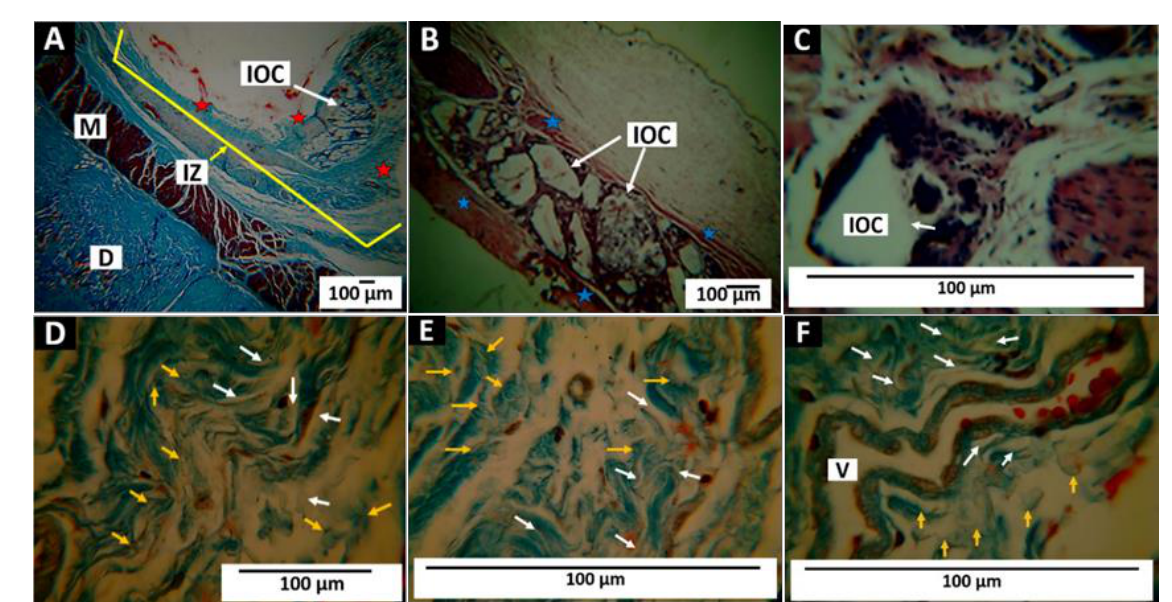
Figure 12. Subdermal implantation of F2 (InterOss Collagen). ( A ) Image at 4×. TM technique. ( B ) Image at 10×. H-E technique. ( C ) Image at 100×. H-E technique. ( D ) Image at 100×. MT technique. ( E ) 100×. TM technique. ( F ) 100×. MT technique. D: Dermis. M: Muscle. IZ: Implantation zone. IOC: InterOss Collagen. Stars: fibrous capsule. White arrow: Collagen fiber fragments of the material. Yellow arrow: Bovine apatite fragments of the material. V: blood vessel.